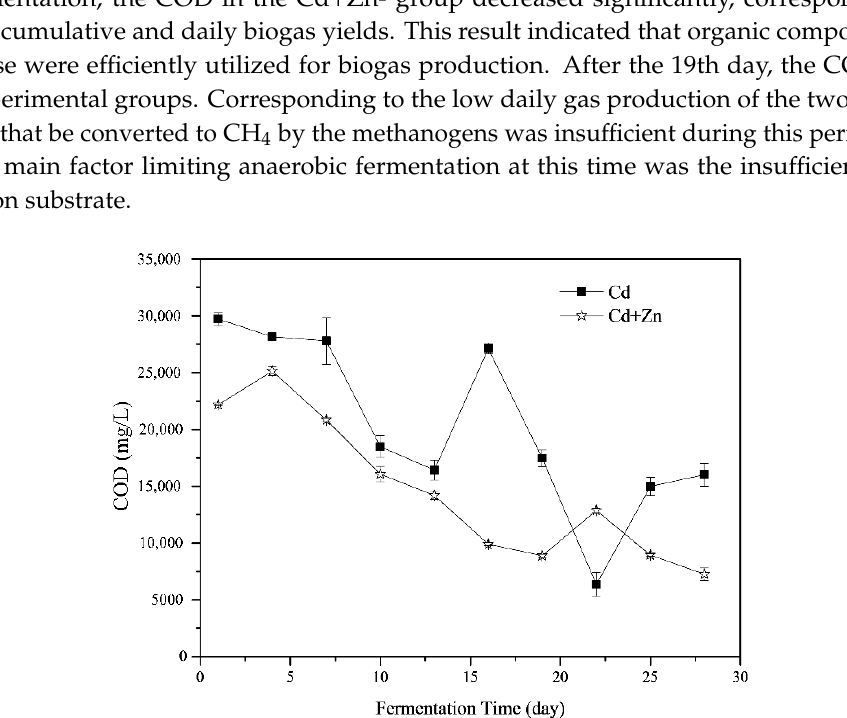
Figure 5. Impact of Cd and Cd+Zn addition on ammonia nitrogen (NH 4+ -N) concentrations during the fermentation.